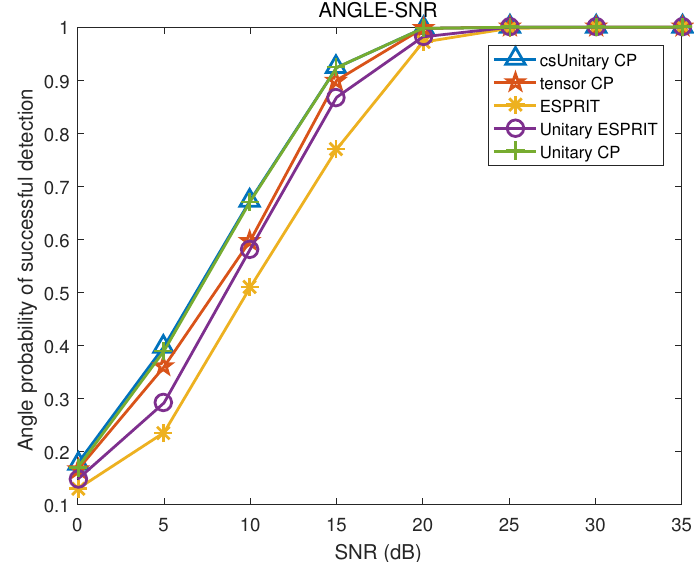
Figure 10. PSD of angle estimation versus SNR.